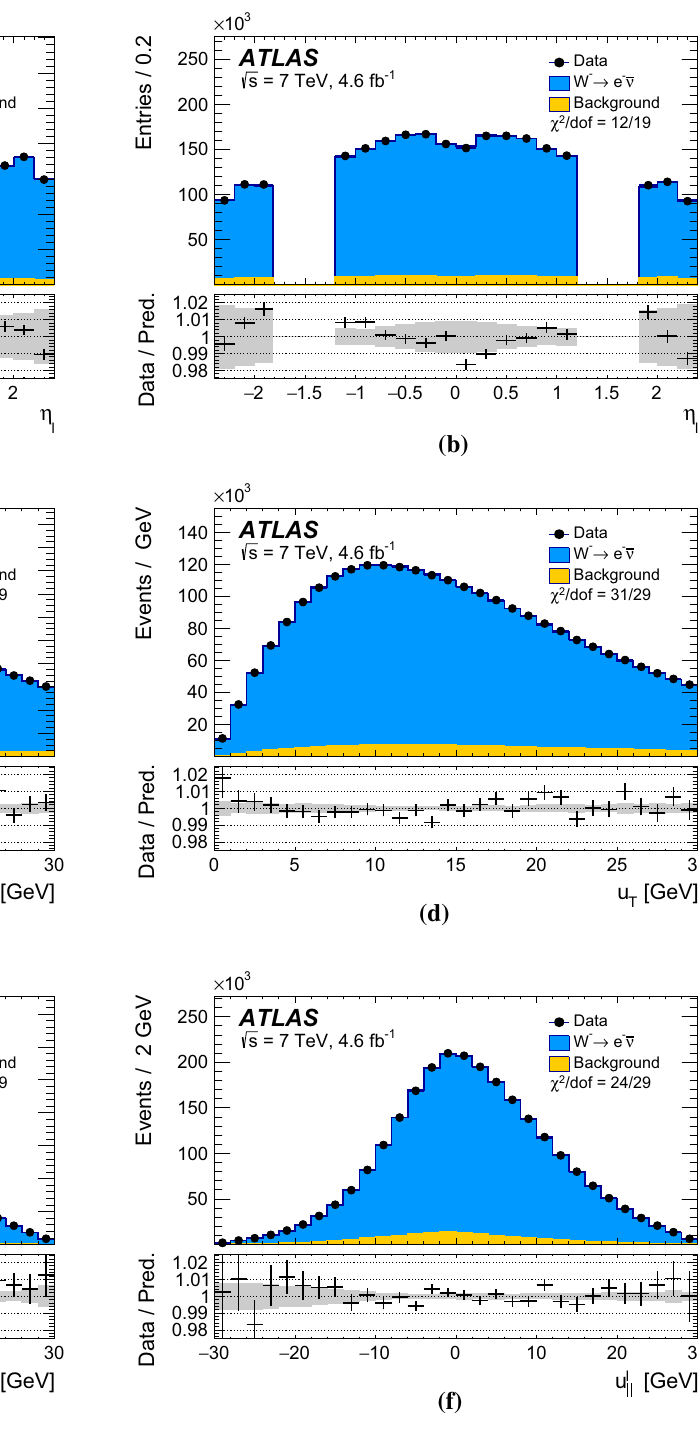
Fig. 19 The a , b η (cid:7) , (c,d) u T , and e , f u (cid:7) (cid:5) distributions for a , c , e W + events and b , d , f W − events in the electron decay channel. The data are compared to the simulation including signal and background con- tributions. Detector calibration and physics-modelling corrections are applied to the simulated events. The lower panels show the data-to-